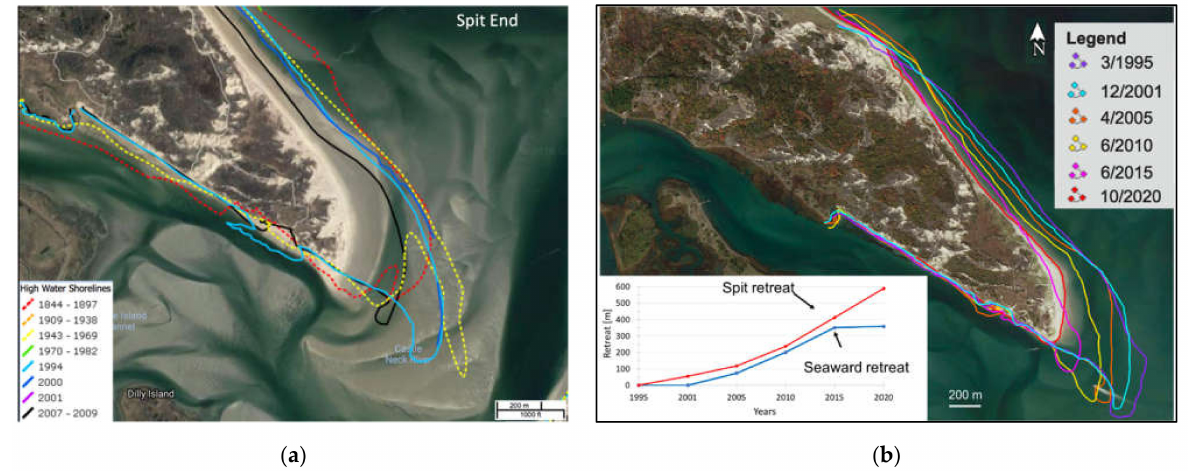
Figure 10. Shoreline change along southeastern Castle Neck. ( a ) Long-term shoreline changes for the period 1844 to 2009; ( b ) recent shoreline changes between 2003 and 2019. Background imagery from Landsat, April